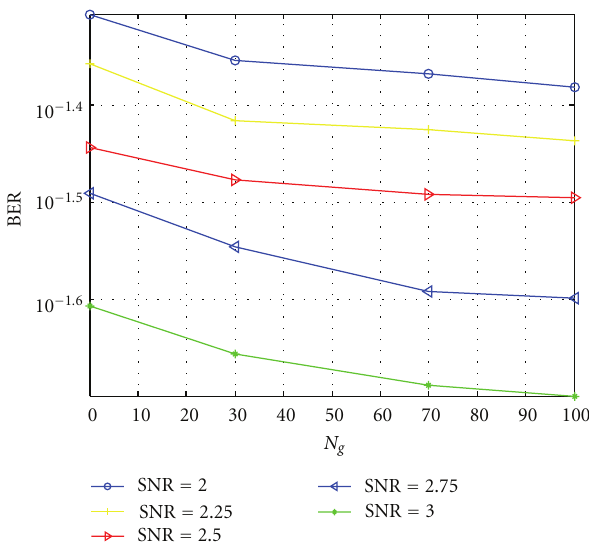
Figure 4: BER versus number of generations.